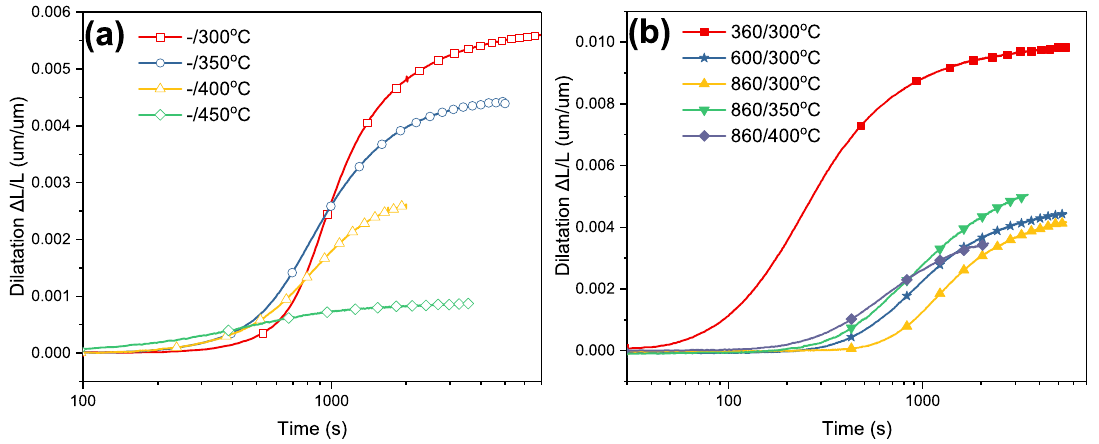
Figure 2. Relationship between dilatation ( ∆ L / L ) and holding time in different isothermal conditions of ( a ) undeformed and ( b ) deformed at different temperature. The number on the left and right side of the symbol “/” denotes the deformation and isothermal temperature